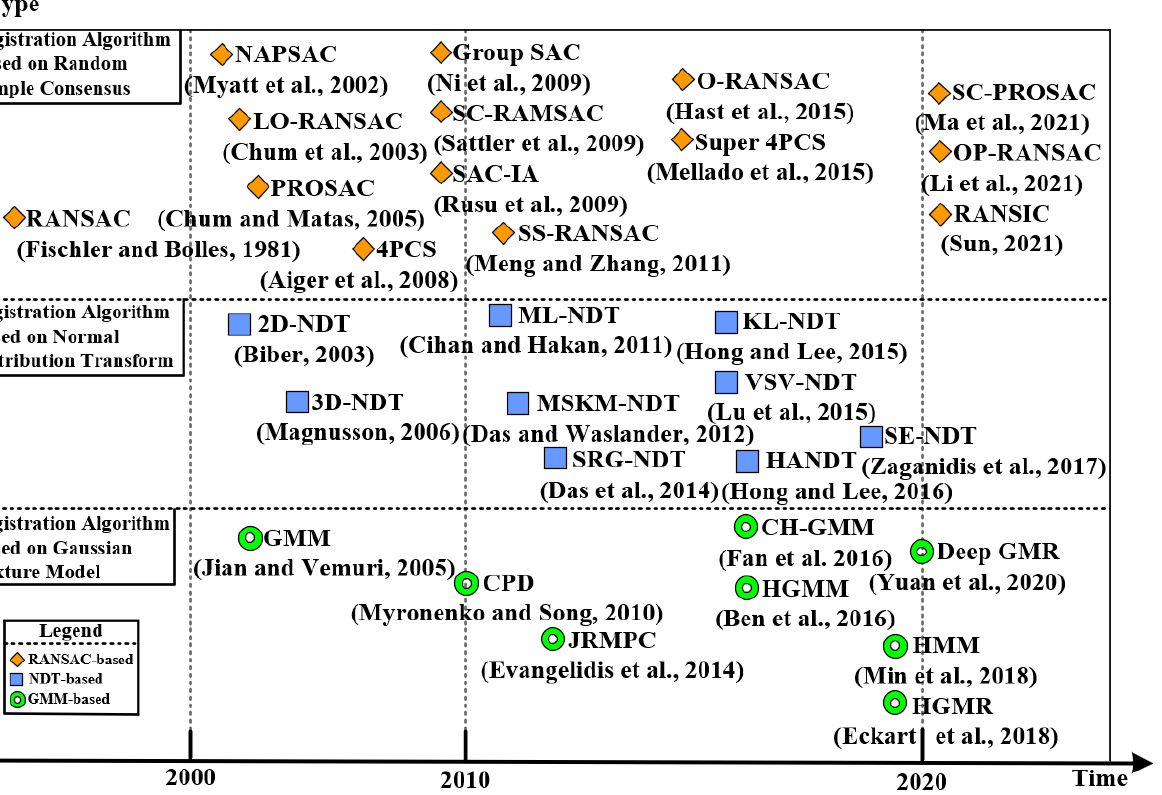
Figure 4. Chronological Overview of Registration Algorithm Based on Probability Stochastic Distri- bution Model [72 – 99].